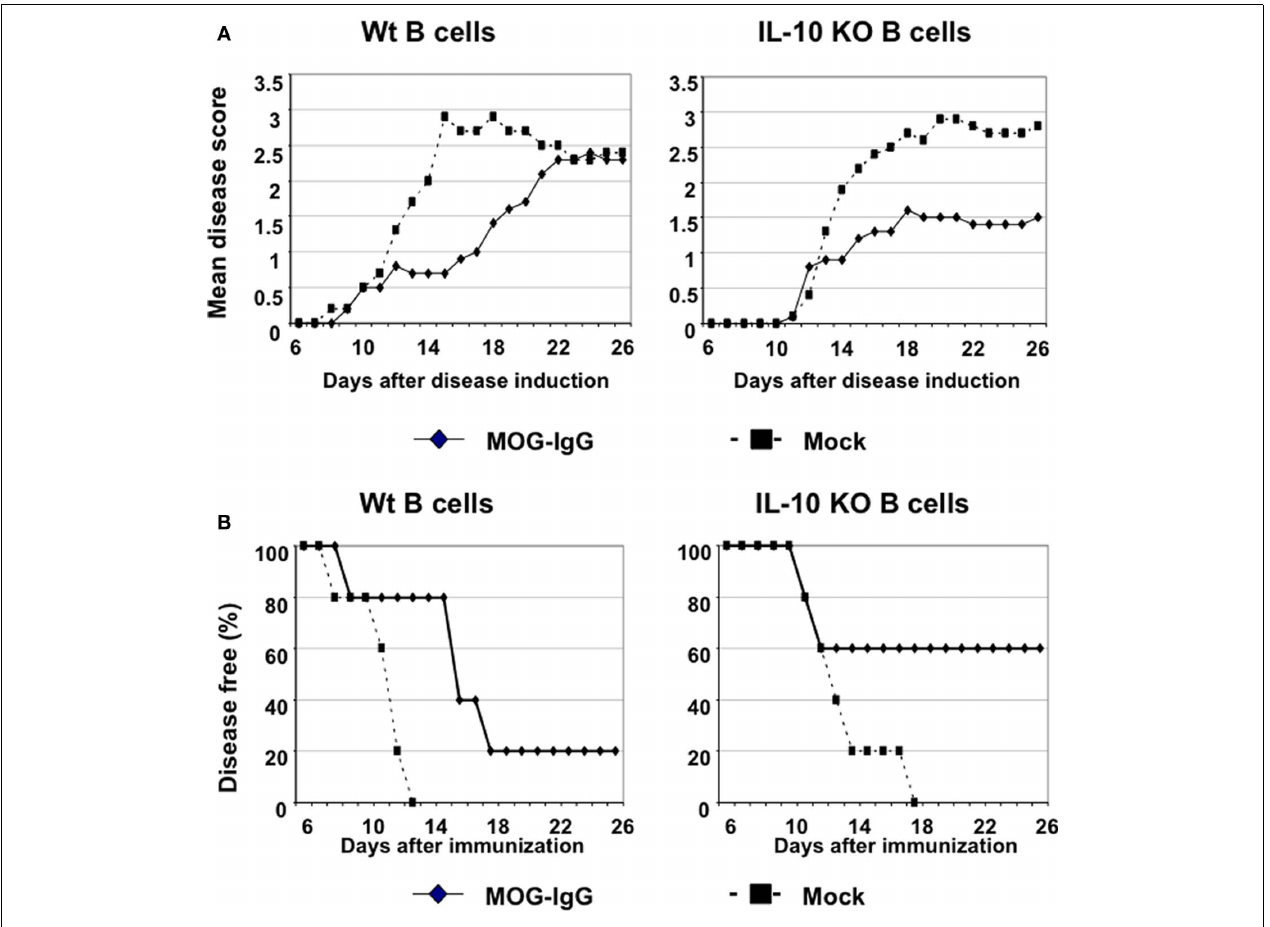
using a 0–5 scoring system. Mean disease score (A) and the disease incidence (B) were shown. As the mice that received MOG–Ig transduced B cells from wt C57BL/6 donors (left panels), the mice that received MOG–Ig transduced IL-10 KO B cells (right panels) also had ameliorated disease symptoms and decreased disease incidence, as compared with the